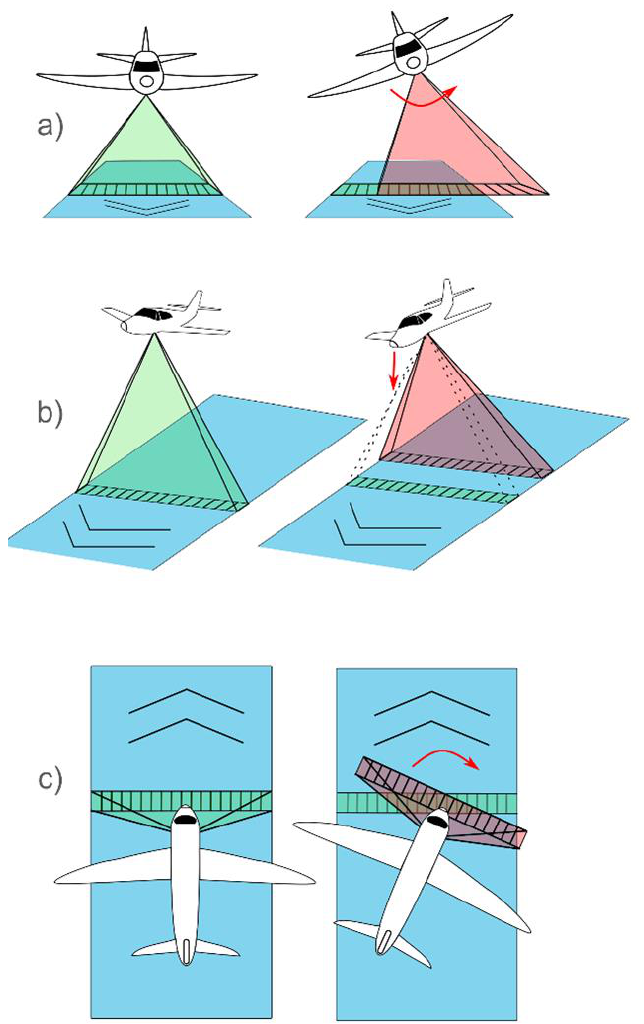
Figure 9. The effect of platform attitude on the look direction of a sensor. ( a ) A “rolled” aircraft will cause a sensor to image an area adjacent to the intended flight line. ( b ) A change in platform pitch will cause the sensor to image a portion of the flight line that is not directly below it; rapid changes in pitch may therefore cause duplicate imaging of some targets (downward pitch aiming the sensor backward) or gaps (upward pitch aiming the sensor ahead). ( c ) A change in yaw will angle the view of the sensor so consecutive rows of pixels are not parallel, resulting in gaps and duplication.